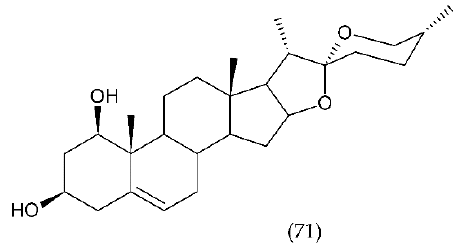
Figure 21. Chemical structure of ruscogenin (RUS) (71).